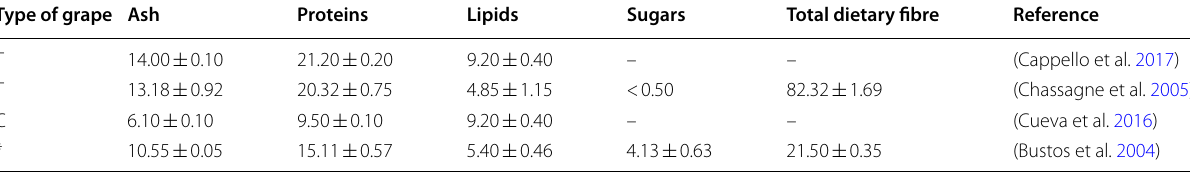
Samples represented by the letter T correspond to Tempranillo grapes ; sample represented by the letter C corresponds to Vitis coignetiae Pulliat ex Planch Crimson variety grapes; sample represented by the icon * means that the grape variety was not informed